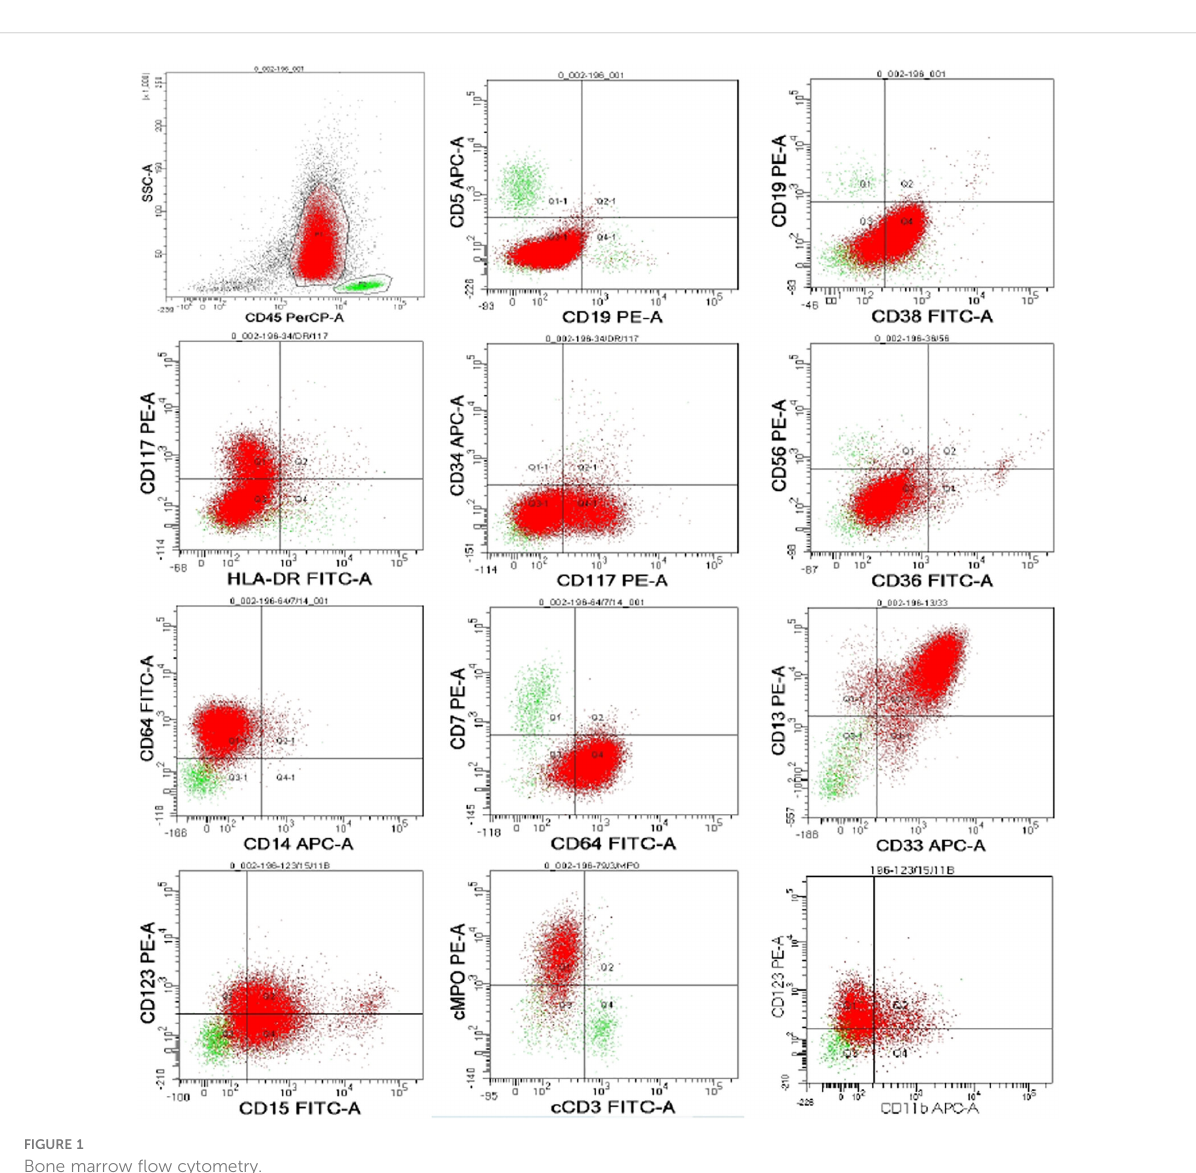
FIGURE 1 Bone marrow fl ow cytometry.